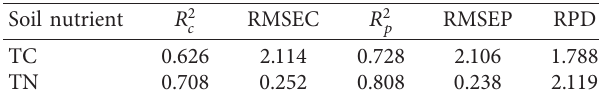
Table 6: Prediction results of TC and TN concentration with different numbers of standard data by